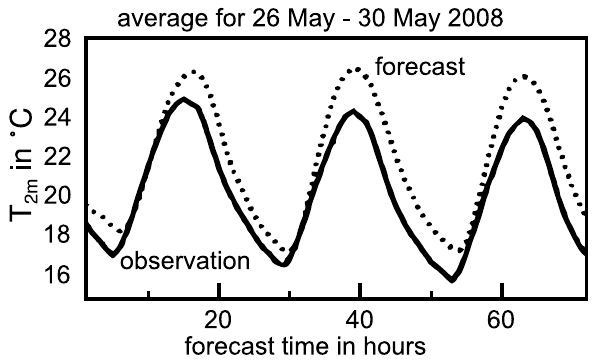
Fig. 1. Predicted T 2m as a function of forecast hour compared with measurements for the area of SW-Germany (see area (cid:127) in Fig. 2). Each day a forecast for three days was simulated; afterwards the results and the corresponding observations were averaged as a function of forecast hour to identify systematic differences between forecast and observation (U. Damrath, DWD, personal communica- tion,